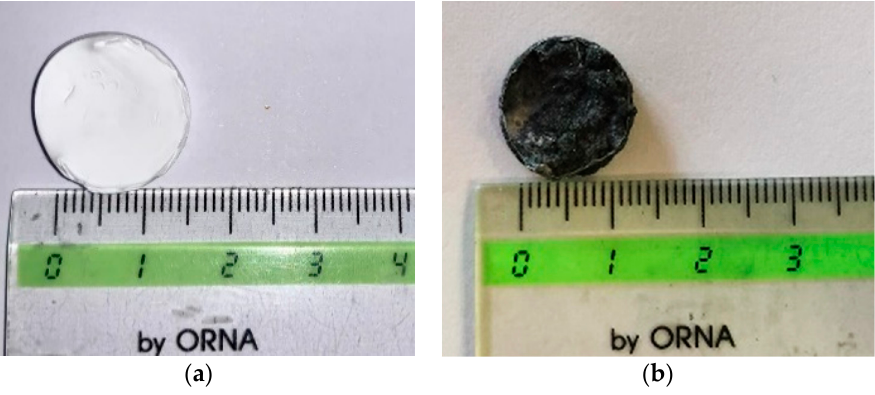
Figure 5. Photographs of the PVDF HFP aerogel ( a ) and of the RuO 2 loaded PVDF HFP composite aerogel ( b ).